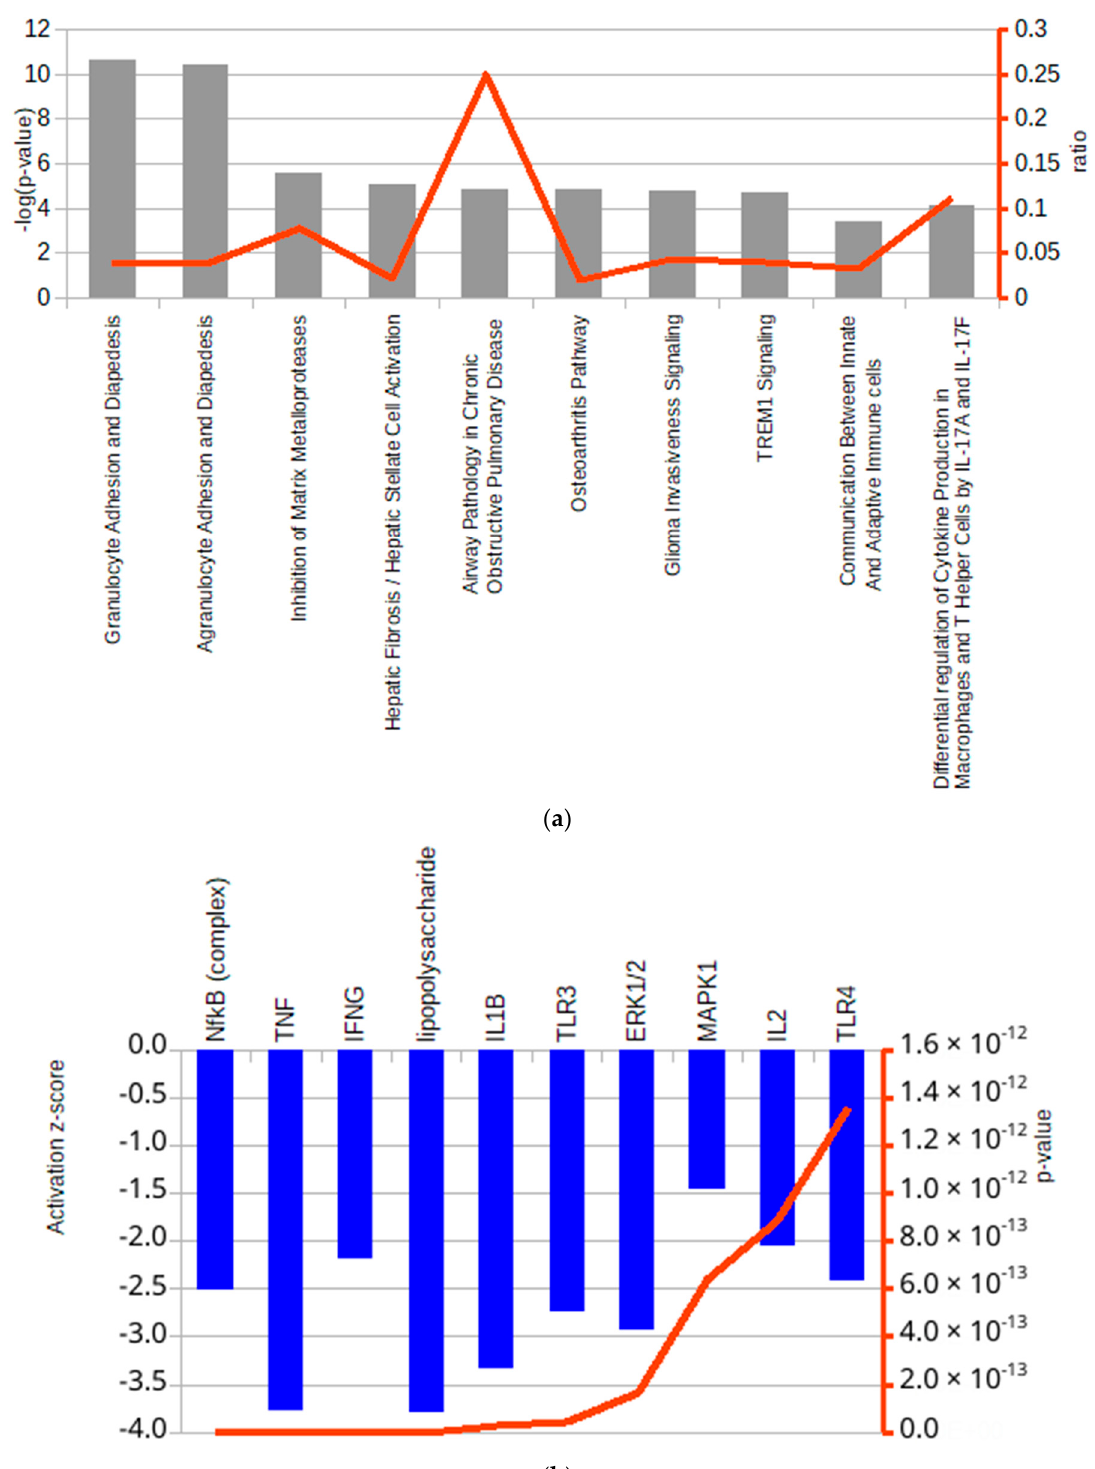
Figure 3. Top ten canonical pathways ( a ) and top ten up ‐ stream regulators ( b ) detected as altered by IPA ® analysis. In ( a ) the ‘ratio’ value is the ratio between altered genes and total genes in the pathway, and in ( b ) bars represent the pathway z ‐ score, the red line indicates the p ‐ value of the prediction.